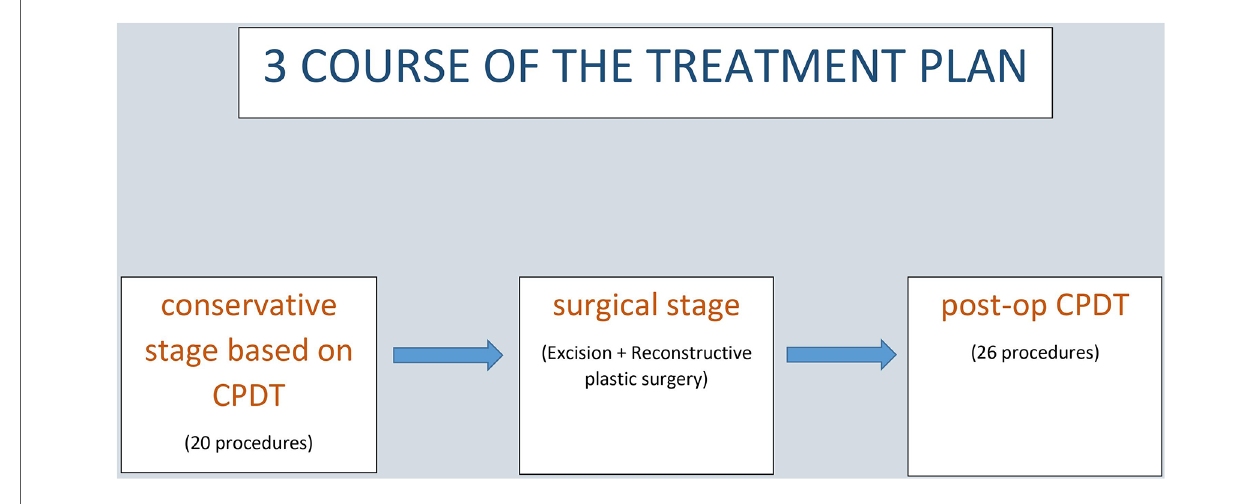
FIGURE 2 Flow diagram illustrating the multiphase therapeutic methods approach to the development of treatment plan against secondary genital lymphedema. CDPT, combination of decongestant physical